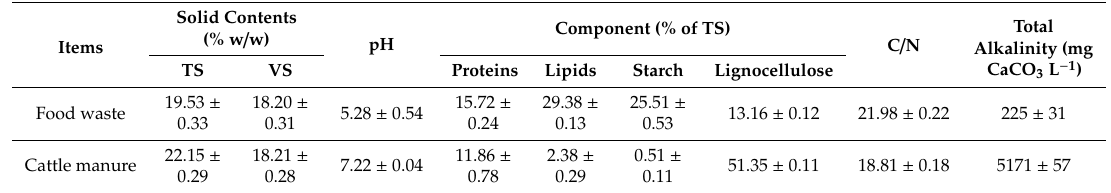
Table 1. Substrate composition. TS: total solid, VS: volatile solid.